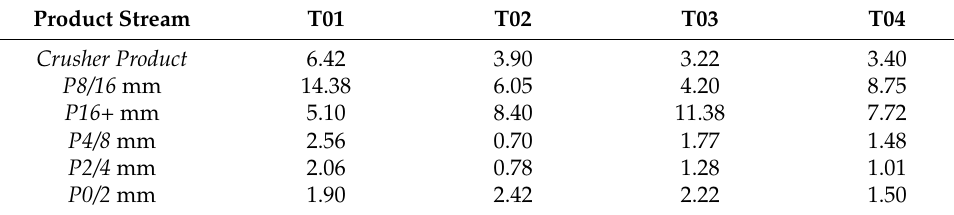
Table 2. RMSE calculation between process simulation and production data.